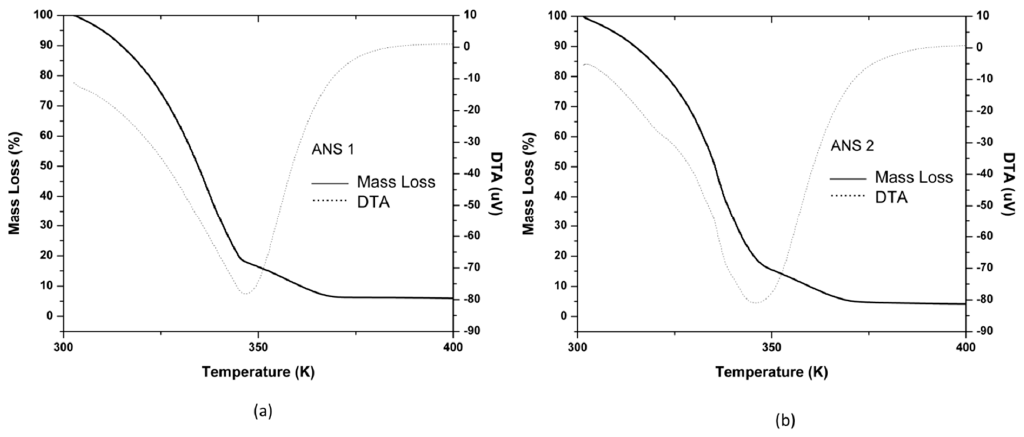
Figure 10. Thermogravimetric analysis (TGA-DTA) for system ANS1 ( a ) and ANS2 ( b ).